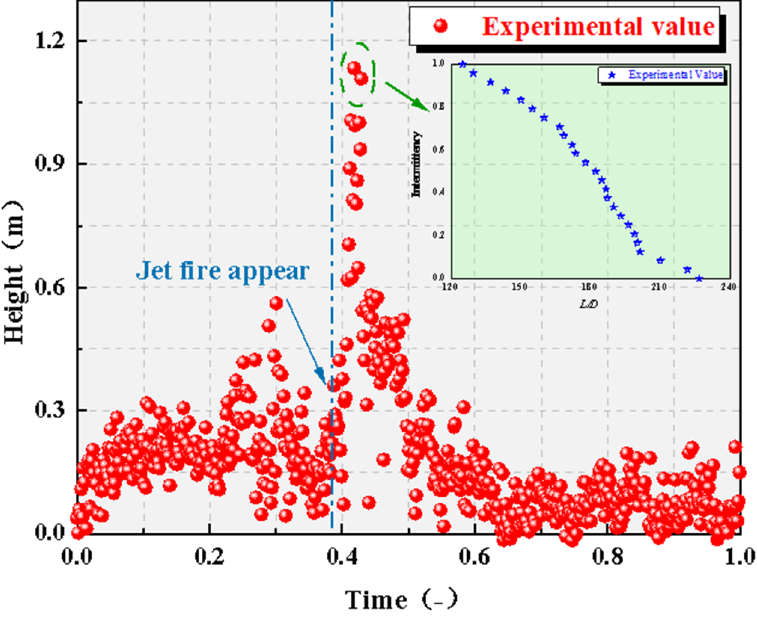
Figure 4. Flame height evolution of the jet fire (D = 0.4 m/d = 10 cm). Flame impact is one of the main hazards of jet flames to personnel and equipment.